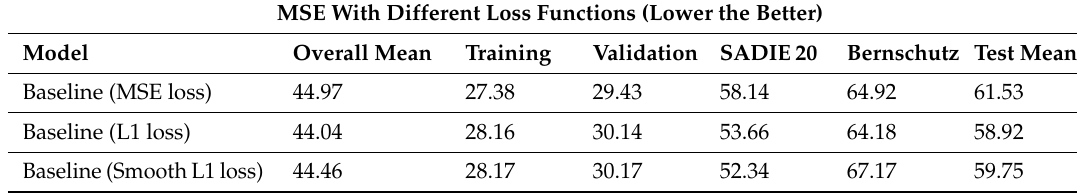
Table 5. Comparison between different loss functions demonstrating that Smooth L1 loss performs the best in SADIE II test